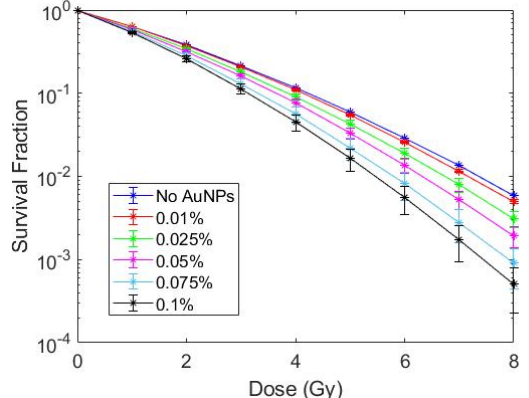
Figure 10. Survival fraction curves determined using MC-LEM method at 2.5 cm depth for varying concentrations of AuNPs in the cytoplasm model. Table 5. Sensitization enhancement ratio (SER) calculated from Figure 10.